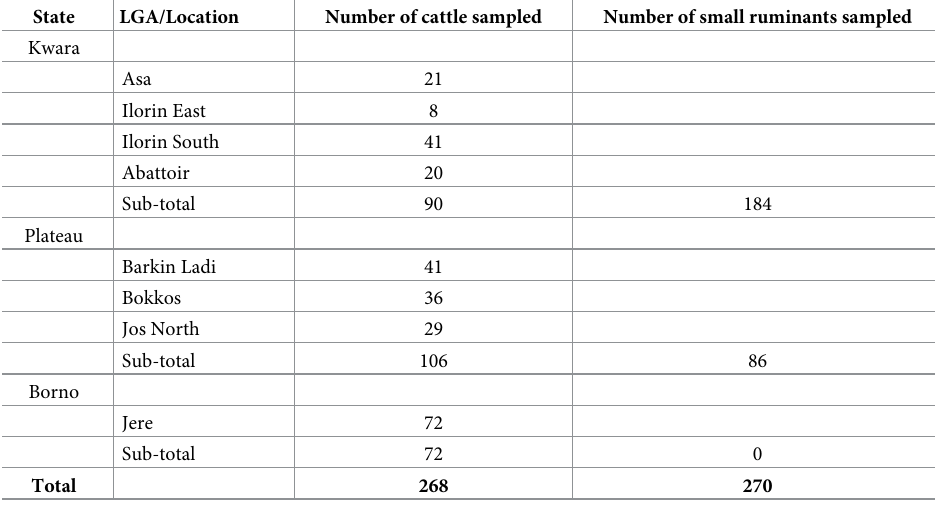
Table 1. The distribution of cattle and small ruminants sampled from three northern Nigerian